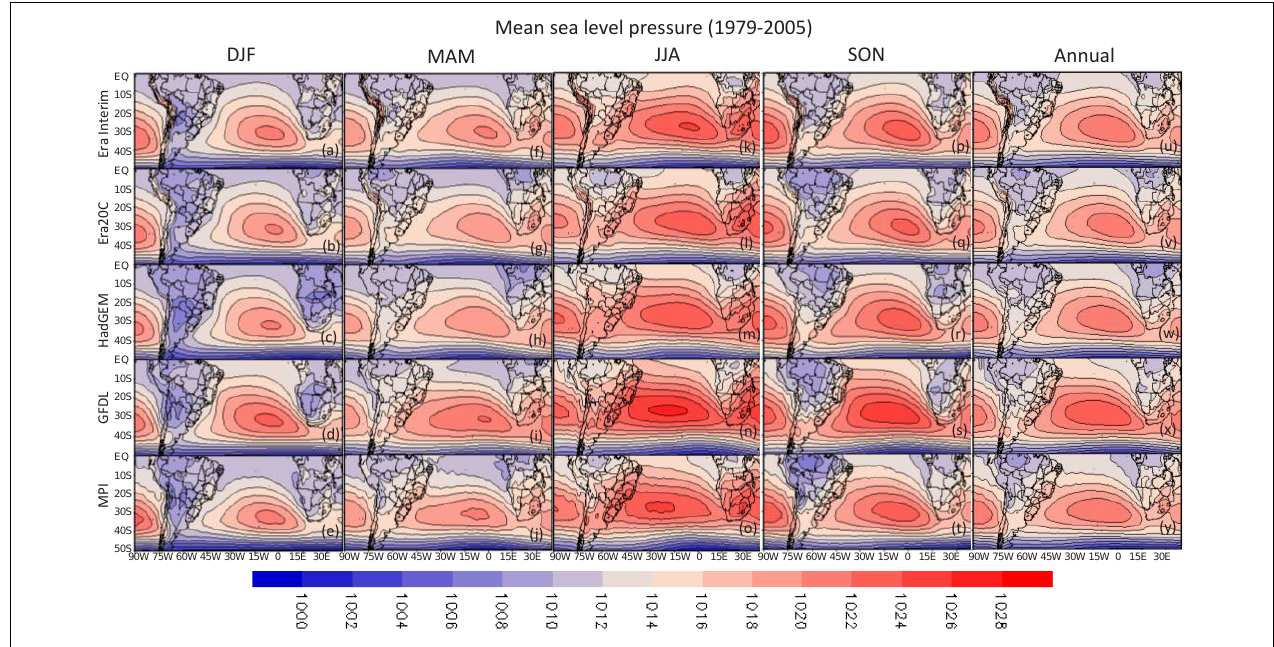
FIGURE 1 | Seasonal and annual climatologies of the mean sea level pressure (hPa) in the present climate (1979–2005) from ERA-Interim (a,f,k,p,u) and ERA-20C (b,g,l,q,v) reanalyses, and HadGEM (c,h,m,r,w) , GFDL (d,i,n,s,x) , and MPI global climate models (e,j,o,t,y) . Isobars interval is 2 hPa.